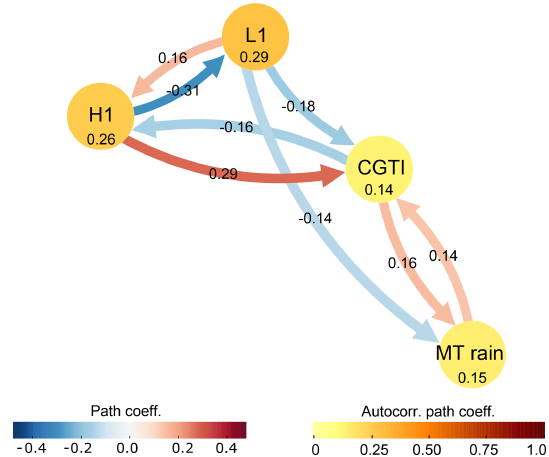
Figure 5. Mid-latitude wave train. CEN built with the MT rain- fall, CGTI, L1 and H1 (as identified in Fig. 4a) for the period 1979–2017. The strength of causal links expressed by the standard- ized regression path coefficients and autocorrelation path coeffi- cients is shown above the arrows and inside the circles, respectively. All links have a lag of 1 week. Only causal links with corrected p < 0 . 05 are shown. See the main text for